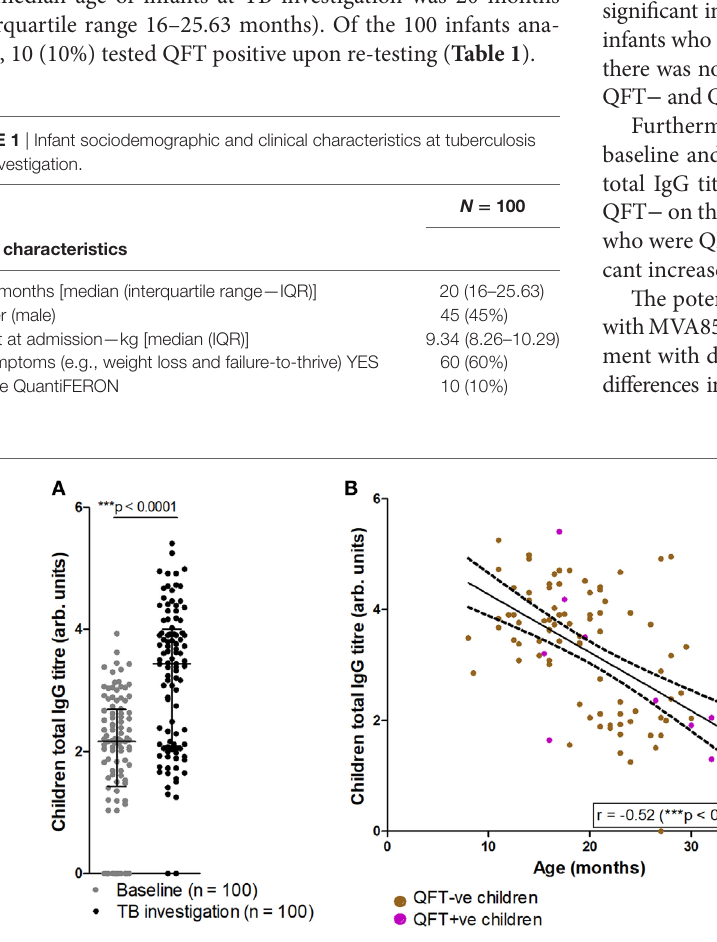
FigUre 2 | Comparisons of tuberculosis (TB) investigation total IgG responses to baseline total IgG, age and QFT outcome. Total serum IgG in participants at baseline and upon TB investigation visit ( n = 100) as measured by enzyme-linked immunosorbent assay (a) . Total IgG titers vs. age in months at TB investigation ( n = 97), with samples from QFT positive participants indicated in purple (B) ; overlaid are the line-of-best-fit and 95% confidence bands (dashed lines). Association between age at TB investigation and QFT result (c) . Antibody titers are presented as log-transformed arbitrary values. The Wilcoxon matched-pairs signed rank test was used to assess significance of the comparison in (a) , and the Mann–Whitney test was used to assess significance in (c) . The Spearman correlation was used to assess the strength of the correlation in (B) .